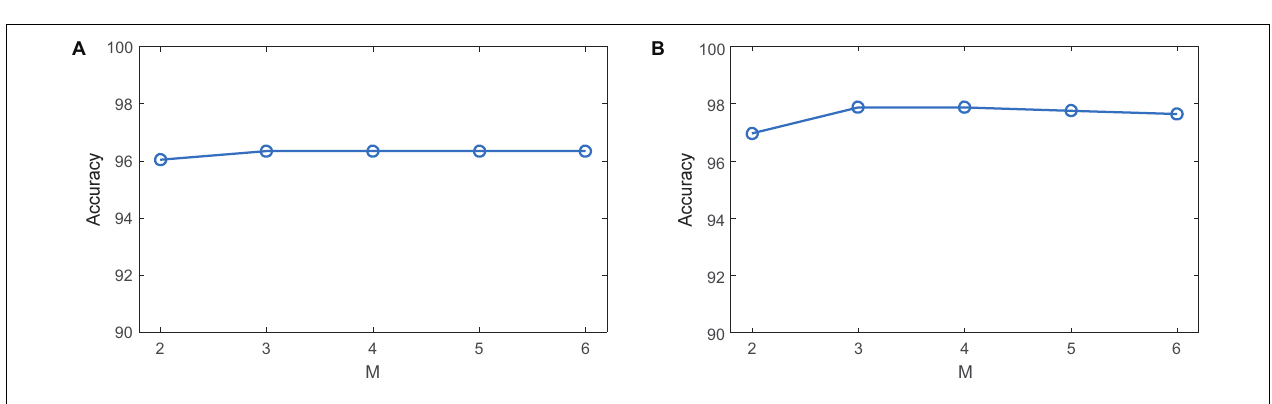
FIGURE 8 | Parameter sensitivity M of CDLLC on (A) the Cheng dataset and (B) the REMBRANDT